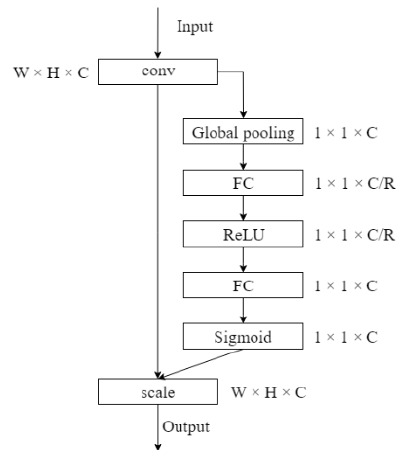
Figure 3. SE module structure.(FC: fully connected layer, ReLU: rectified linear unit)